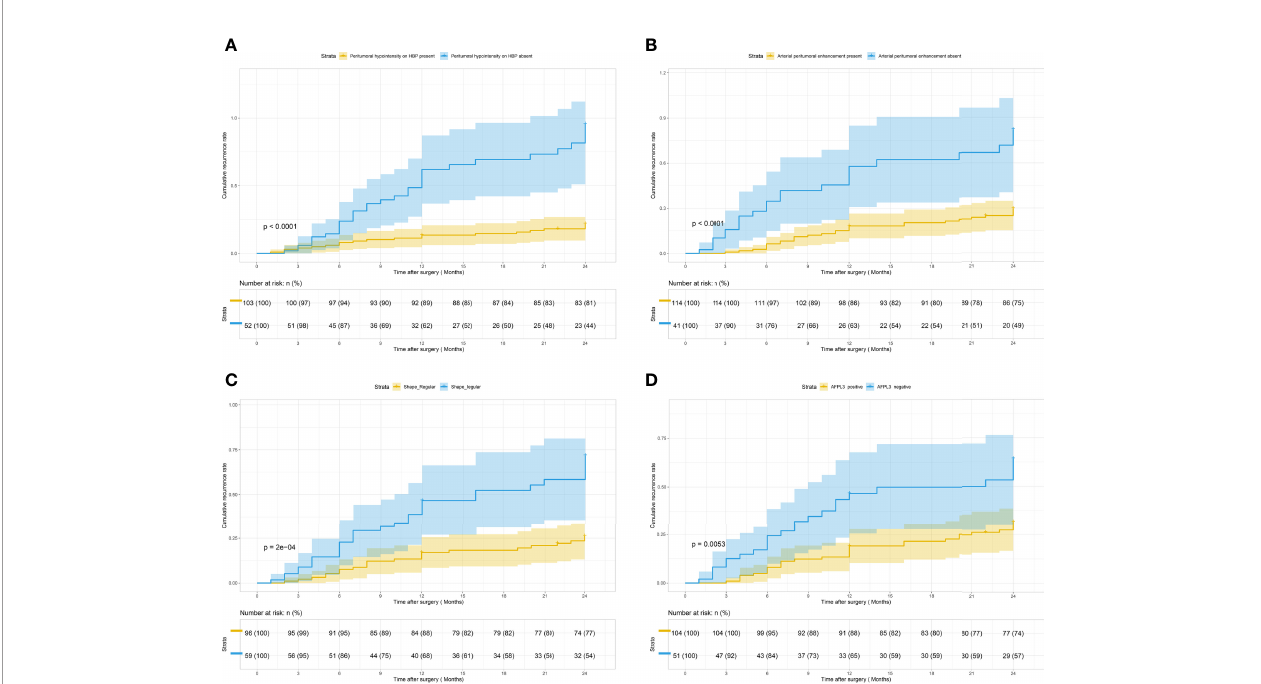
FIGURE 2 | Kaplan – Meier curves for early recurrence showing that signi fi cant difference is seen between patients classi fi ed as follows: (A) peritumoral hypointensity on HBP (present) and peritumoral hypointensity on HBP (absent) (log-rank test, p < 0.001); (B) arterial peritumoral enhancement (present) and arterial peritumoral enhancement (absent) (log-rank test, p < 0.001); (C) shape (regular) and shape (irregular) (log-rank test, p < 0.001); (D) AFP-L3 (positive) and AFP-L3 (negative) (log- rank test, p =